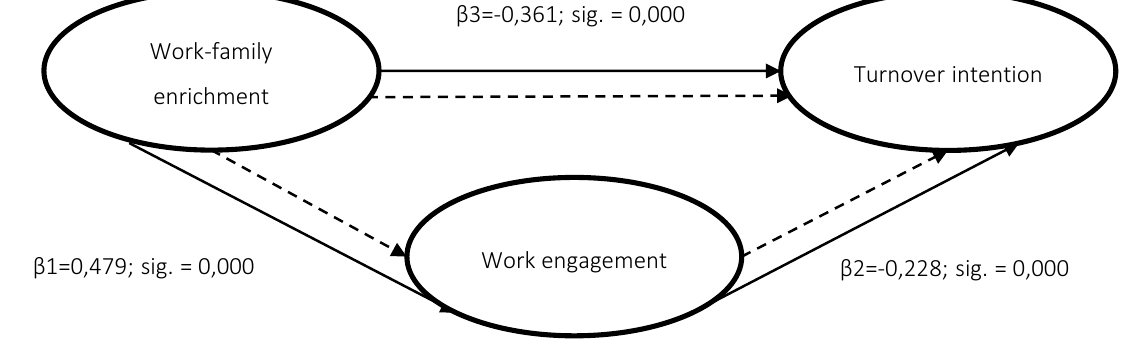
Work Figure 1. Analysis using SEM